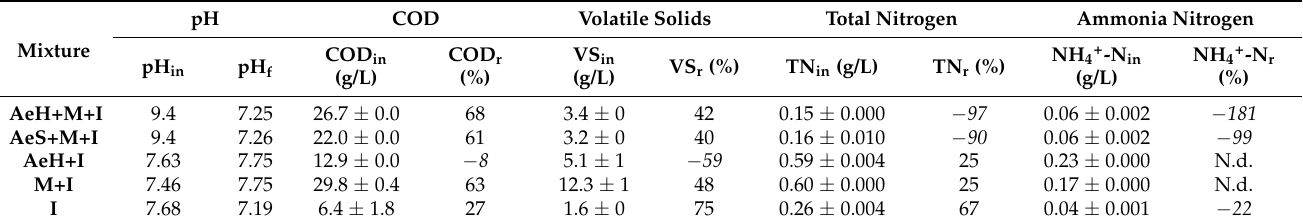
Table 2. Performance of anaerobic digestion of microalgae fermentation wastes.